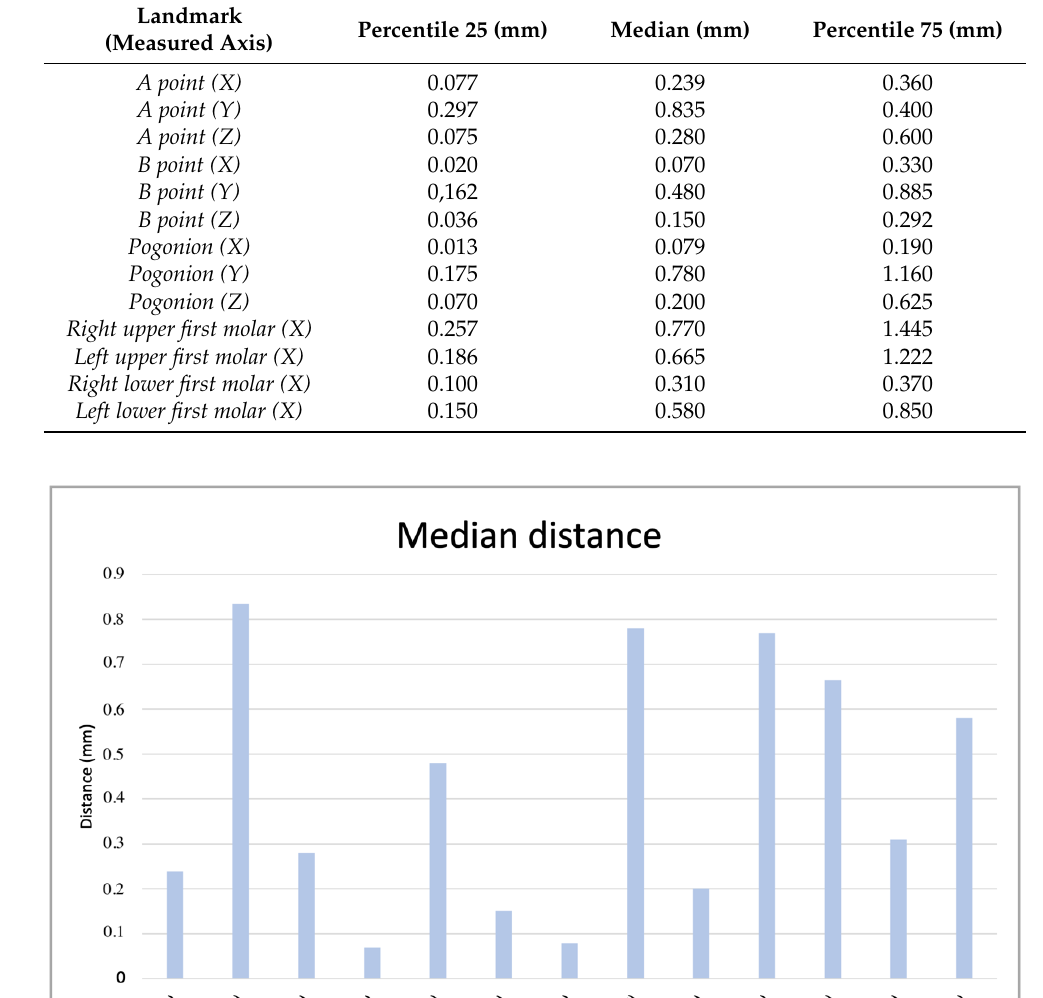
Table 1. Median and 25th and 75th percentiles for all differences between surgical planning and actual postoperative results at the selected landmarks for the 40 patients. The x axis represents the mediolateral (or horizontal) direction, the y axis, the anteroposterior direction, and the z axis, the inferosuperior (or vertical) direction.